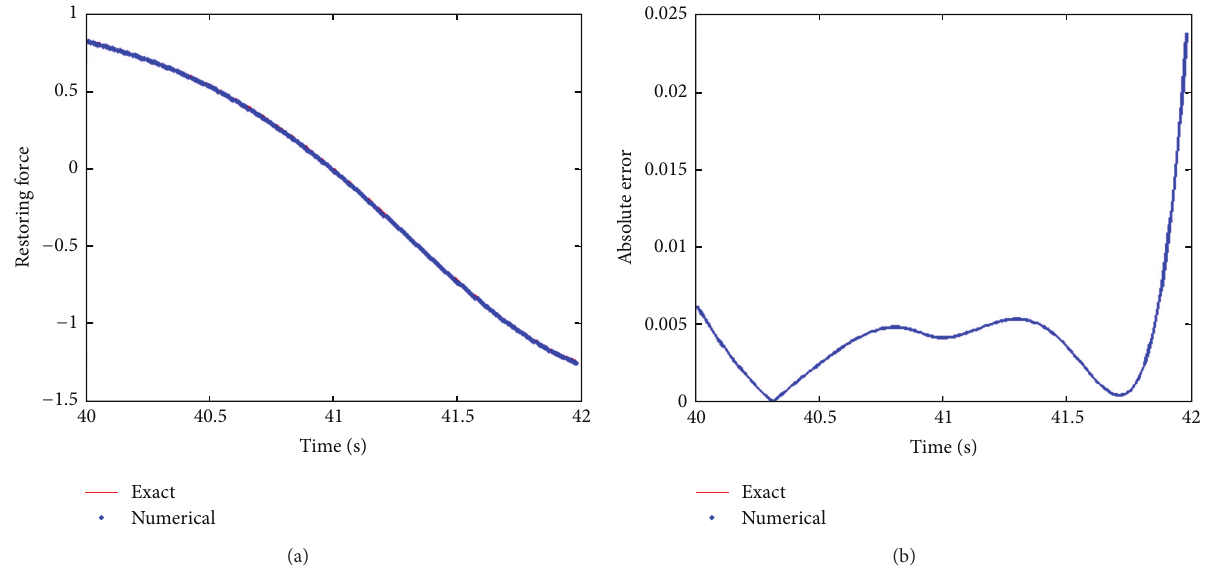
Figure 13: For Example 3, (a) comparing estimated and exact restoring forces with 𝜎 = 5 % and (b) displaying the estimation error of restoring force.